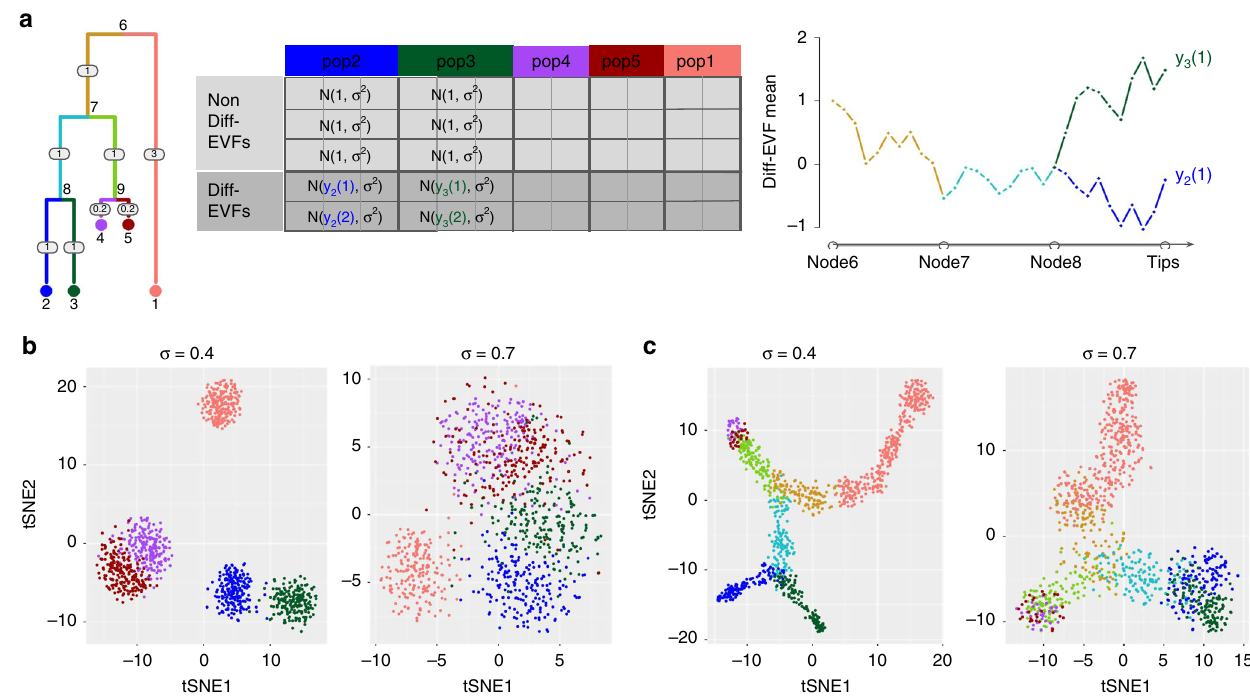
Fig. 3 Extrinsic variation. a Illustration of generating a diverse set of cell states with SymSim. The tree represents the relationship between cells. The numbers on the edges are branch lengths; the node numbers indicate the ID of the respective subpopulation (each subpopulation is represented by a single position [leaf] in the tree). The matrix to the right depicts the derivation of EVF values. Each row corresponds to an EVF (only two are Diff-EVF), each column corresponds to a position in the tree, and the content speci fi es the distribution from which the EVF values are drawn. We use the notation y a (b) to represent the expected value of EVF b in position a in the tree. The rightmost plot depicts the derivation of these expected values with Brownian motion. We use subpopulations 2 and 3 as examples for both discrete cases (sampling only cells within the subpopulations) or continuous (sampling cells along the trajectories from the root progenitor state [node 6] to the two target subpopulations [nodes 2 and 3]). b tSNE plots of fi ve discrete populations generated from the tree structure shown in a . Different values of σ give rise to different heterogeneity of each population. c tSNE plots of continuous populations generated from the same tree. The colors correspond to the colors on branches in the tree shown in a . When increasing σ , cells are more scattered around the main paths which follow the tree structure. Data used to plot b, c can be found in Source